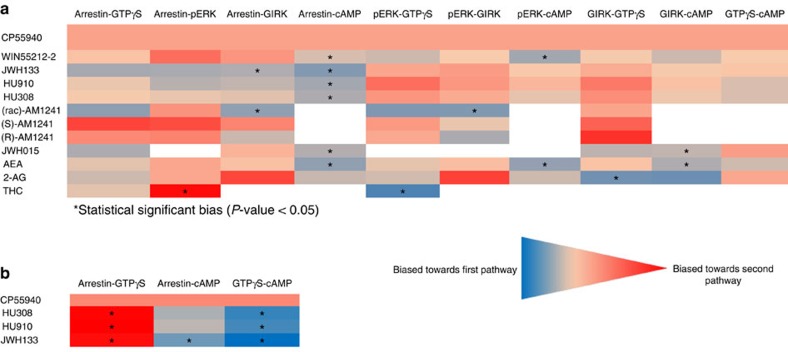
Heatmap of ΔΔlogR values resulting from the operational analysis.The operational analysis was performed using the procedure described in the Supplementary Information, with data obtained from three independent experiments performed in duplicate. Dark blue indicates bias towards the first pathway, while dark red indicates bias towards the second pathway. White boxes are not determined. (a) The operational analysis on hCB2R was done with all agonists, except HU210, which was tested in only two functional assays due to legal restrictions. Because of error propagation in the analysis, only a few were found to be statistically significant (P<0.05). (b) The operational analysis on mCB2R was done with the three most selective and most broadly active compounds on hCB2R; HU308, HU910 and JWH133. Here, all three ligands showed statistically significant bias towards G-protein signalling. Statistics was performed with one-way ANOVA Holm-Sidak's multiple comparisons test using Graphpad Prism 6.